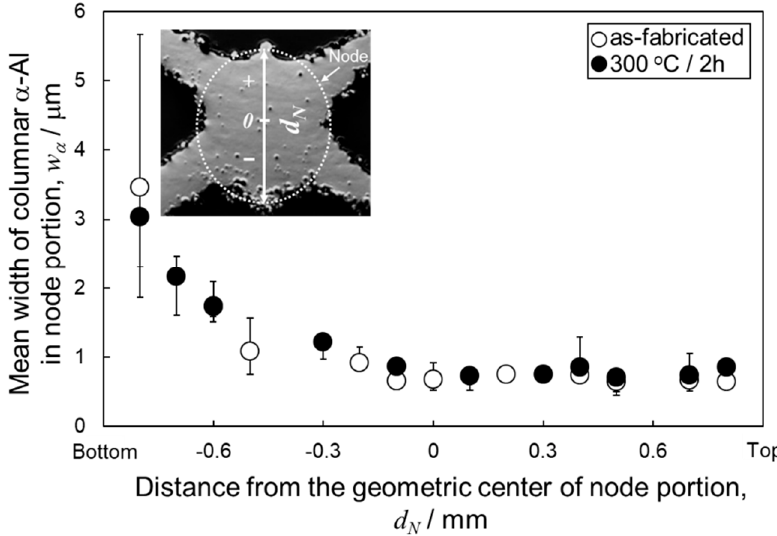
Figure 5. Changes in the mean width of columnar α -Al phases as a function of the vertical distance from the geometric center ( d N ) in the node portion of as-manufactured and 300 ° C annealed specimens.